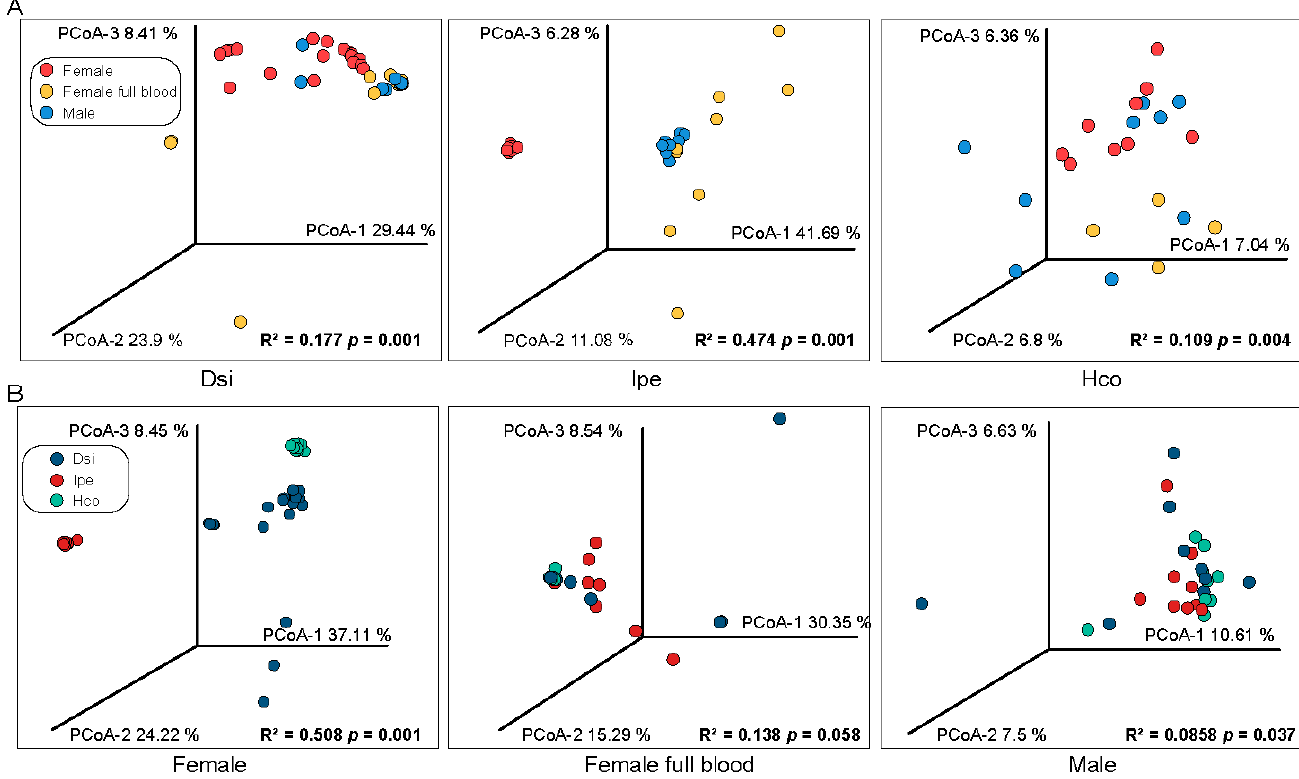
Figure 2. PCA analyses for detecting similarities between different samples. Principal coordinate analysis (OTU level) using Bray–Curtis dissimilarity, comparing identified OTUs within a group ( A ) or species ( B ). Notes: The R 2 and p values generated by the PERMANOVA analysis are shown in the lower right of the plot. Dsi, Dermacentor silvarum ; Ipe, Ixodes spersulcatus ; Hco, Haemaphysalis concinna .